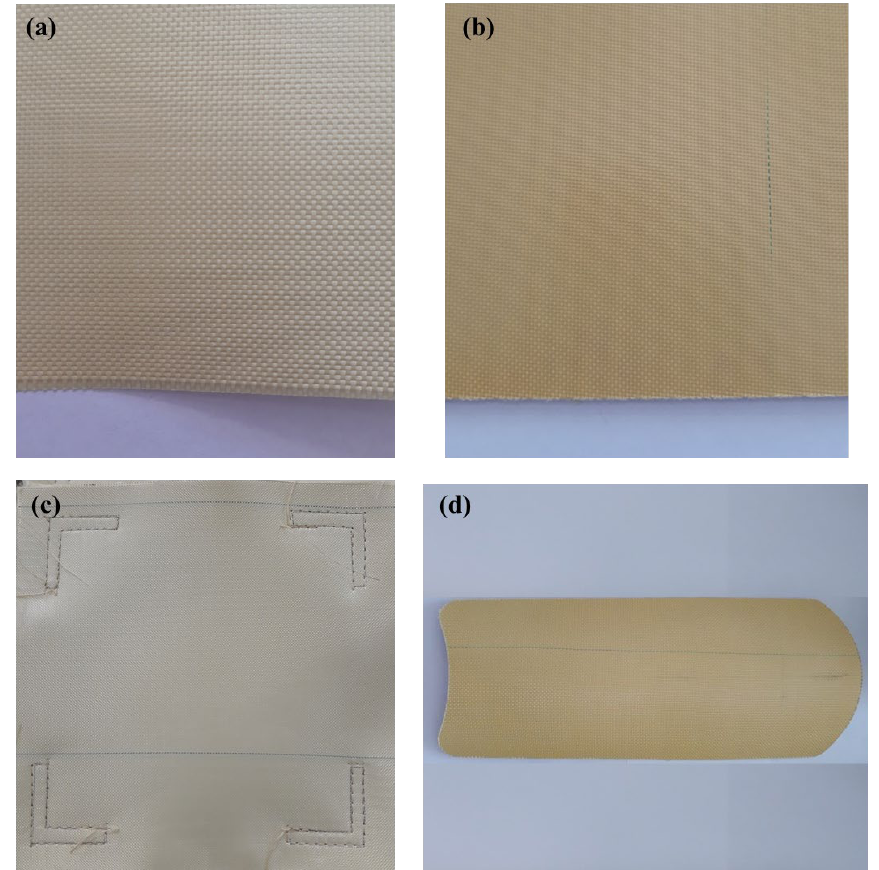
Figure 1. Visual presentation of sample A ( a ), sample B ( b ), ballistic system A ( c ) and ballistic system B ( d ).